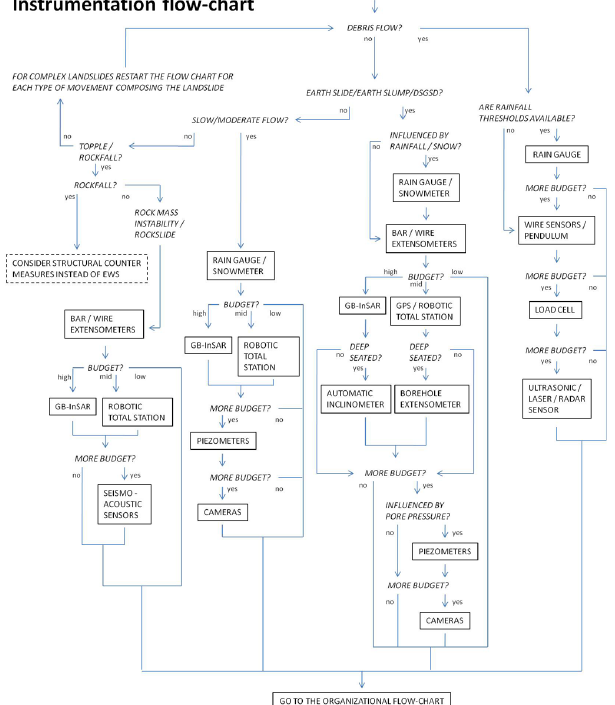
Fig. 2. Flow chart-based toolbox for the choice of instrumentation suitable for slope scale EWSs. The terms “earth slide” and “earth slump” follow the widely accepted classification of Cruden and Varnes (1996) and refers to rotational or translational landslides in granular or cohesive material. DSGSDs (Deep Seated Gravita- tional Slope Deformations) are defined by Agliardi et al. (2001) as slope movements occurring on high relief slopes and with relatively small displacements before the final phase of collapse. GB-InSAR (Ground-Based Interferometric Synthetic Aperture Radar) is an ad- vanced remote sensing monitoring apparatus recently used in land- slide EWSs (Del Ventisette et al., 2011; Intrieri et al., 2012).